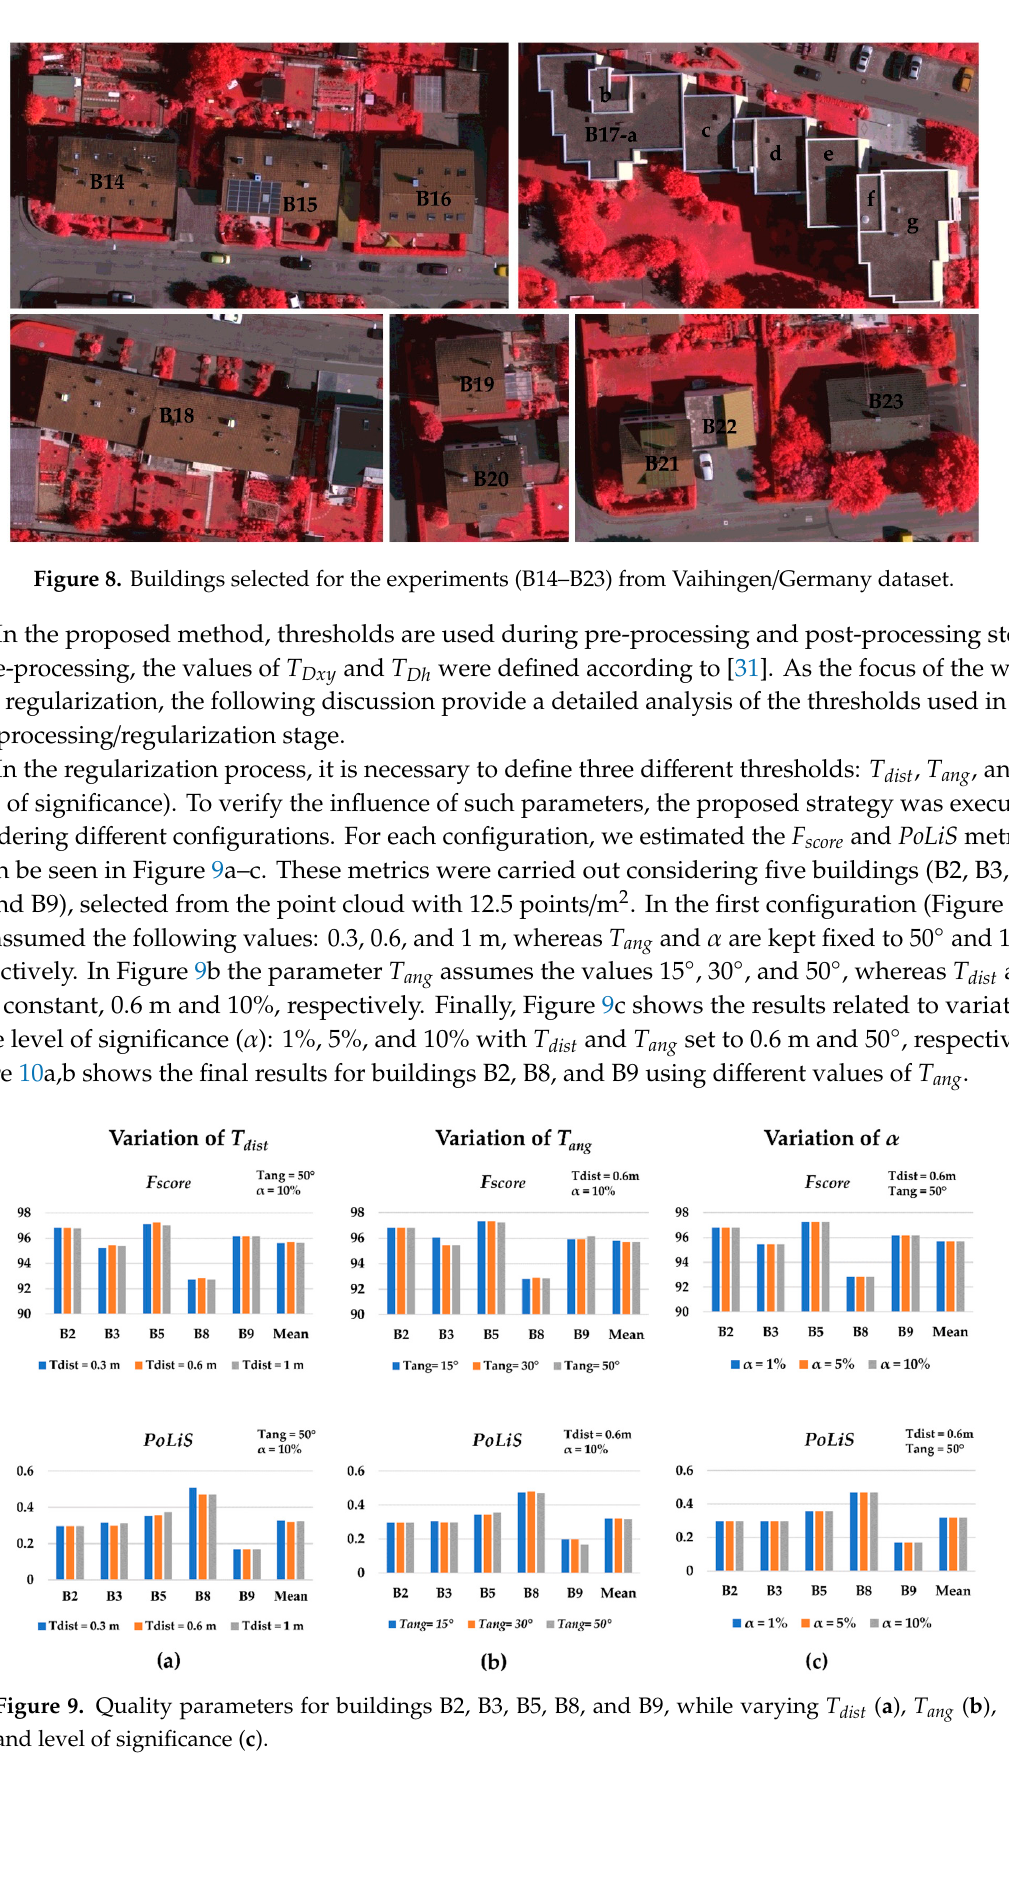
Figure 9. Quality parameters for buildings B2, B3, B5, B8, and B9, while varying T dist ( a ), T ang ( b ), and level of significance ( c ).